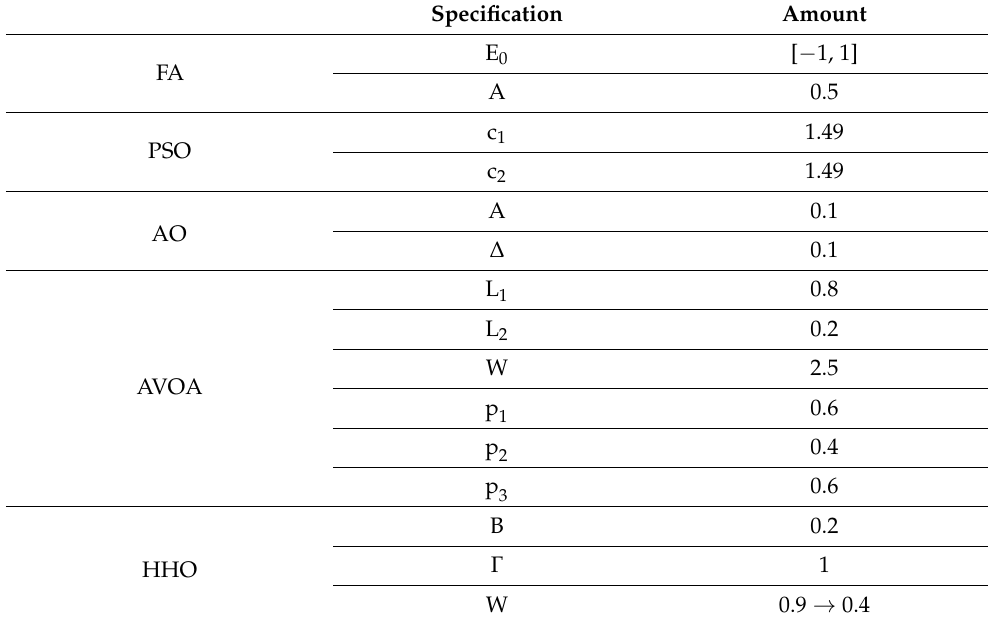
Table 3. Parameters’ settings in the MH